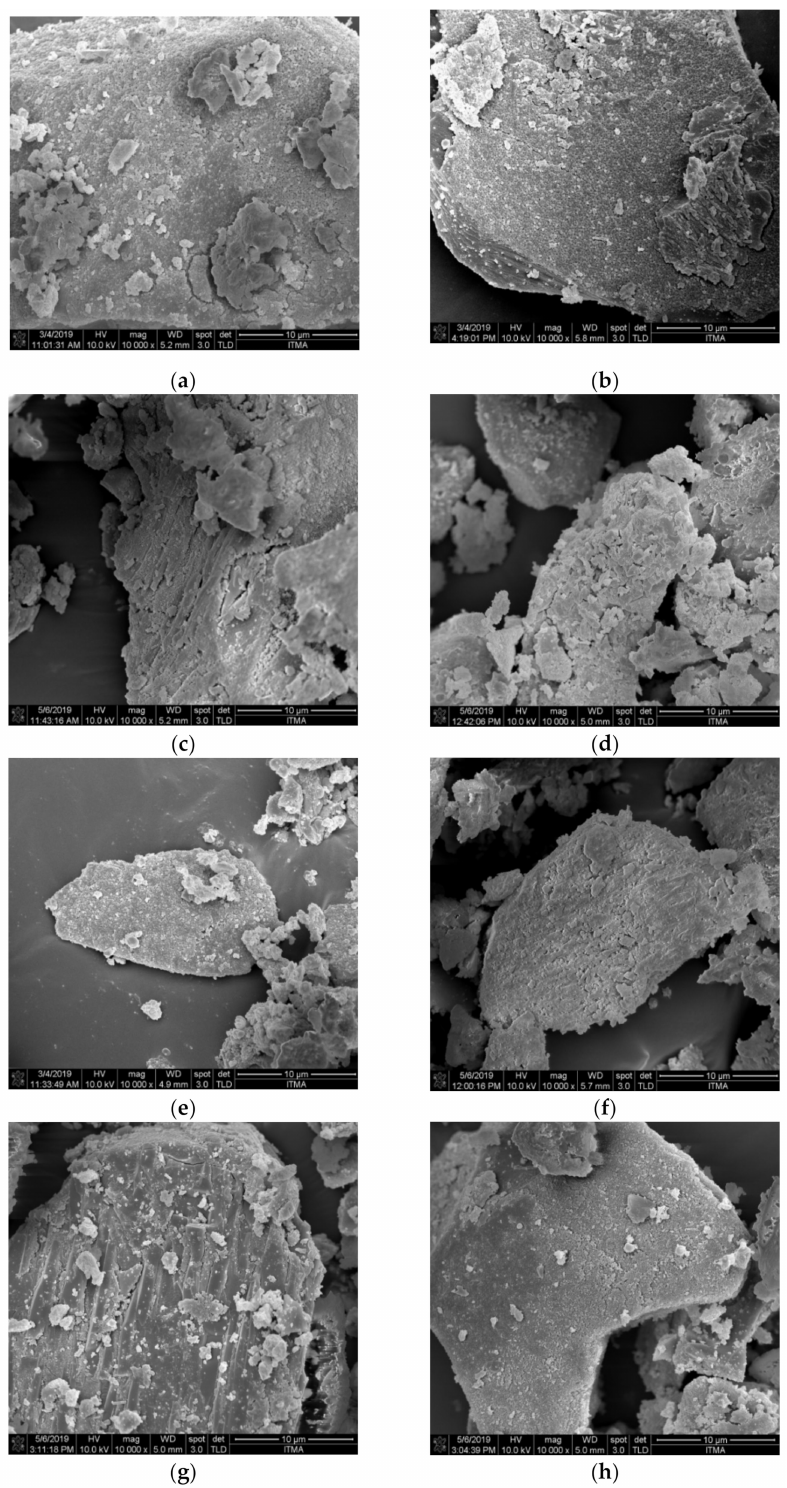
Figure 5. FESEM micrograph under magnification of 10,000 × for samples ( a ) GIC 1 day, ( b ) GIC 7 days, ( c ) GIC 14 days, ( d ) GIC 21 days, ( e ) GIC1 1 day, ( f ) GIC1 7 days, ( g ) GIC1 14 days, and ( h ) GIC1 21